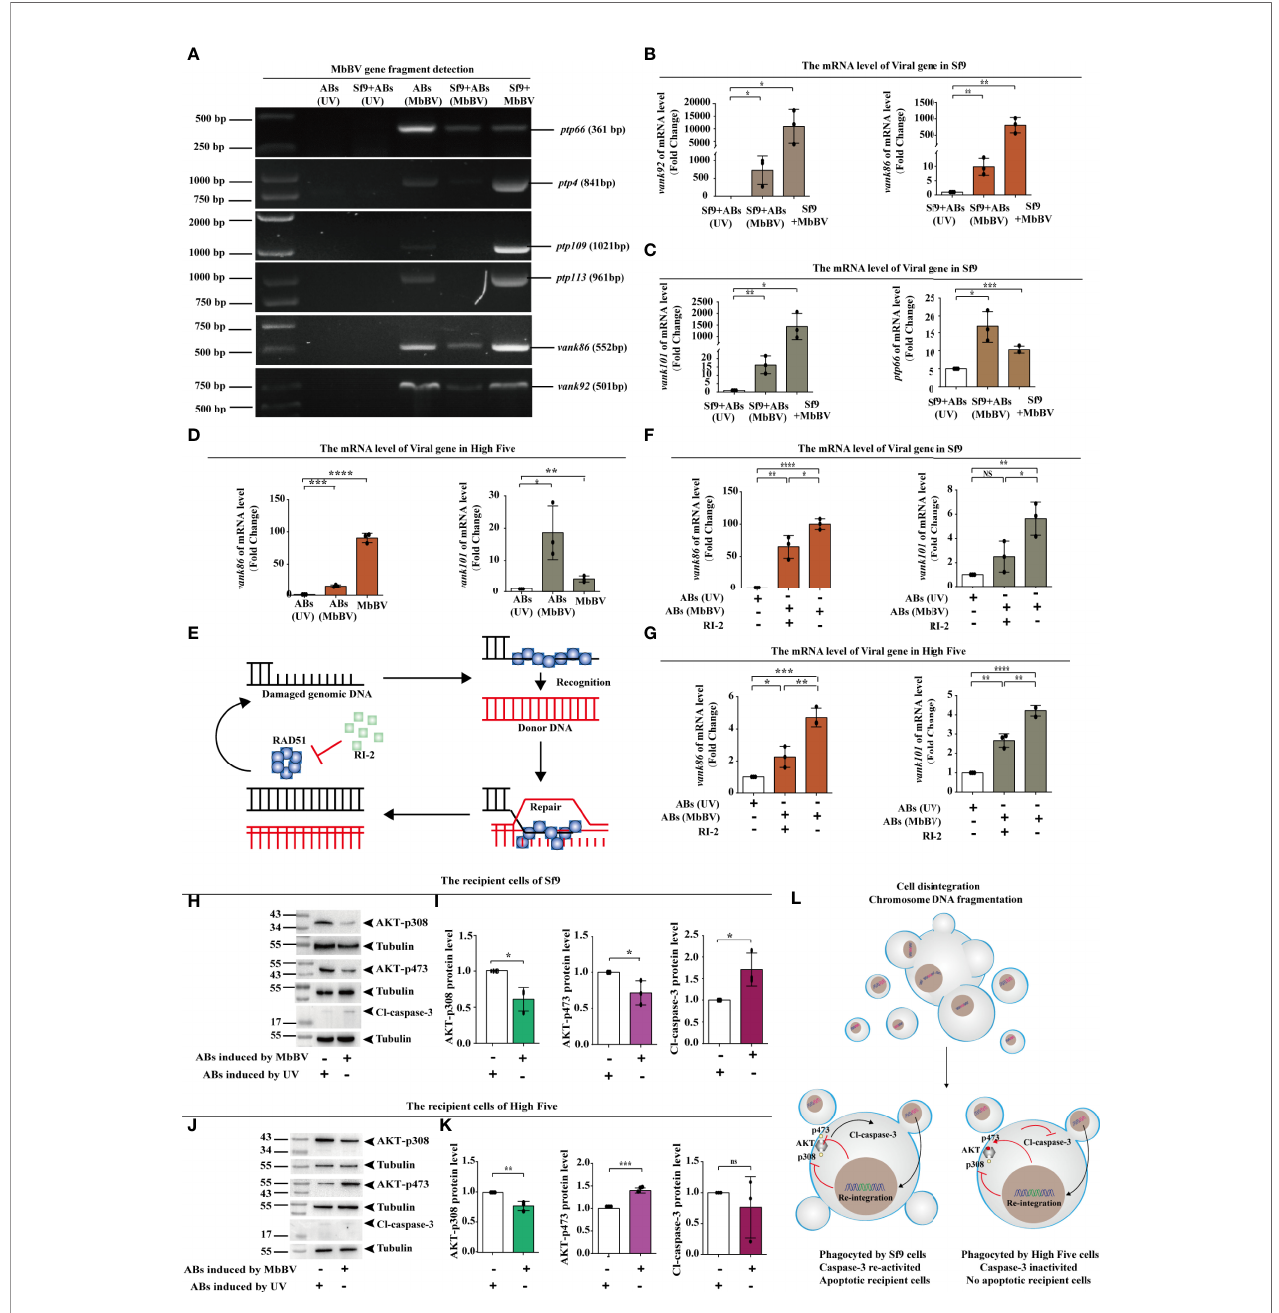
FIGURE 7 | Bracovirus fragments in extracellular vesicles re-integrate into recipient cells. (A) Detection of viral gene fragments in ABs and Sf9 recipient cells. (B , C) Detection of transcription of viral genes, vank92 , vank86, vank101, and PTP66 in Sf9 recipient cells. * p < 0.05, ** p < 0.01, *** p < 0.001, error bars represent SEM. Unpaired Student ’ s t -test with Holm-Sidak method for multiple t test; n = 3. (D) Detection of transcription of viral genes, vank86 and vank101 in High Five recipient cells. * p < 0.05, ** p < 0.01, *** p < 0.001, **** p < 0.0001, error bars represent SEM. Unpaired Student ’ s t -test with Holm-Sidak method for multiple t test; n = 3. (E) Homologous recombination repair system mediated by RAD51. (F, G) Detection of viral genes transcription in recipient cells after inhibition of RAD51. vank86 and vank101 in recipient Sf9 cells (F) and in the recipient High Five cells (G) . * p < 0.05, ** p < 0.01, *** p < 0.001, **** p < 0.0001, ns, no signi fi cant difference, error bars represent SEM. Unpaired Student ’ s t -test with Holm-Sidak method for multiple t test; n = 3. (H, I) Sf9 recipient cells showed decreased expression of AKT-p308 and AKT-p473 (H) , increase Cl-caspase-3 (I) using western blotting. * p < 0.05, ns, no signi fi cant, error bars represent SEM. Unpaired Student ’ s t -test with Holm-Sidak method for multiple t test; n = 3. (J, K) High Five recipient cells showed decreased expression of AKT-p308 and increased expression of AKT-p473 (J) as well as inhibited Cl-caspase-3 (K) . ** p < 0.01, *** p < 0.001, ns, no signi fi cant, error bars represent SEM. Unpaired Student ’ s t -test with Holm-Sidak method for multiple t test; n = 3. (L) Mechanism of re-integrated involvement in apoptotic recipient Sf9 cells and inhibition of migration in the recipient High Five